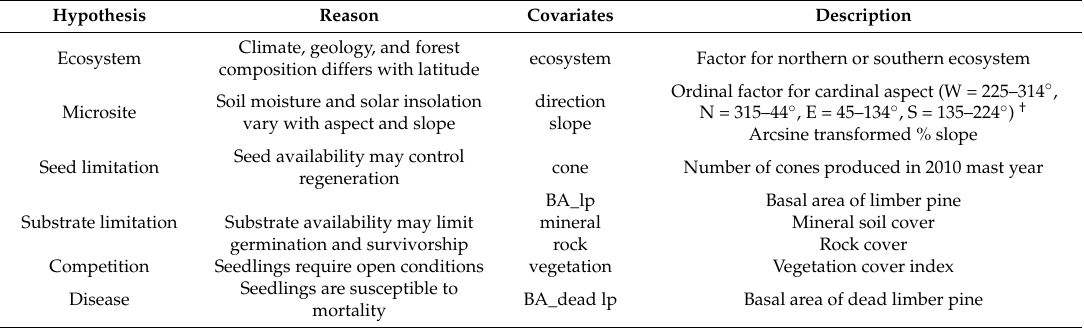
Table 2. A priori hypotheses (models) and their respective covariates and covariate descriptions. Hypothesis Reason Covariates Description Climate, geology, and forest Ecosystem ecosystem Factor for northern or southern ecosystem composition differs with latitude Soil moisture and solar insolation Microsite vary with aspect and